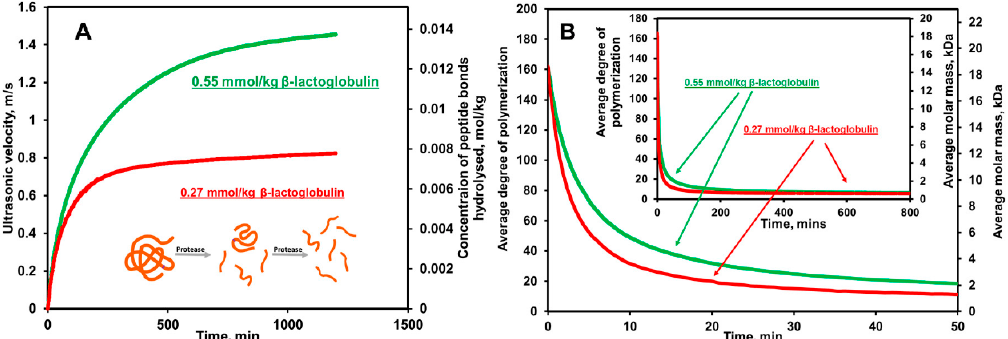
Figure 10. ( A ) Ultrasonic velocity profiles of the hydrolysis of β -lactoglobulin treated with α -chymotrypsin in 0.1-M phosphate buffer, pH 7.8, at 25 °C. The concentration of the peptide bonds hydrolyzed (secondary y-axis) was translated from the ultrasonic velocity profile (primary y-axis) using Equation (9) and ∆ a r = 0.07 ± 0.0015 kg mol − 1 . ( B ) The corresponding profile of the reduction of the average degree of polymerization (primary y-axis) and average molar mass (secondary y-axis), within 50 min of hydrolysis, calculated from the concentration of the peptide bonds hydrolyzed using Equation (14). The insert illustrates the profile at the full time range of the measurement. The concentration of enzyme is 4 µ M. Adopted from Buckin and Altas [73].